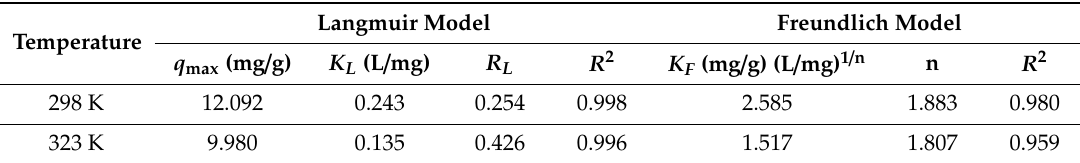
Table 2. Adsorption isotherm parameters.